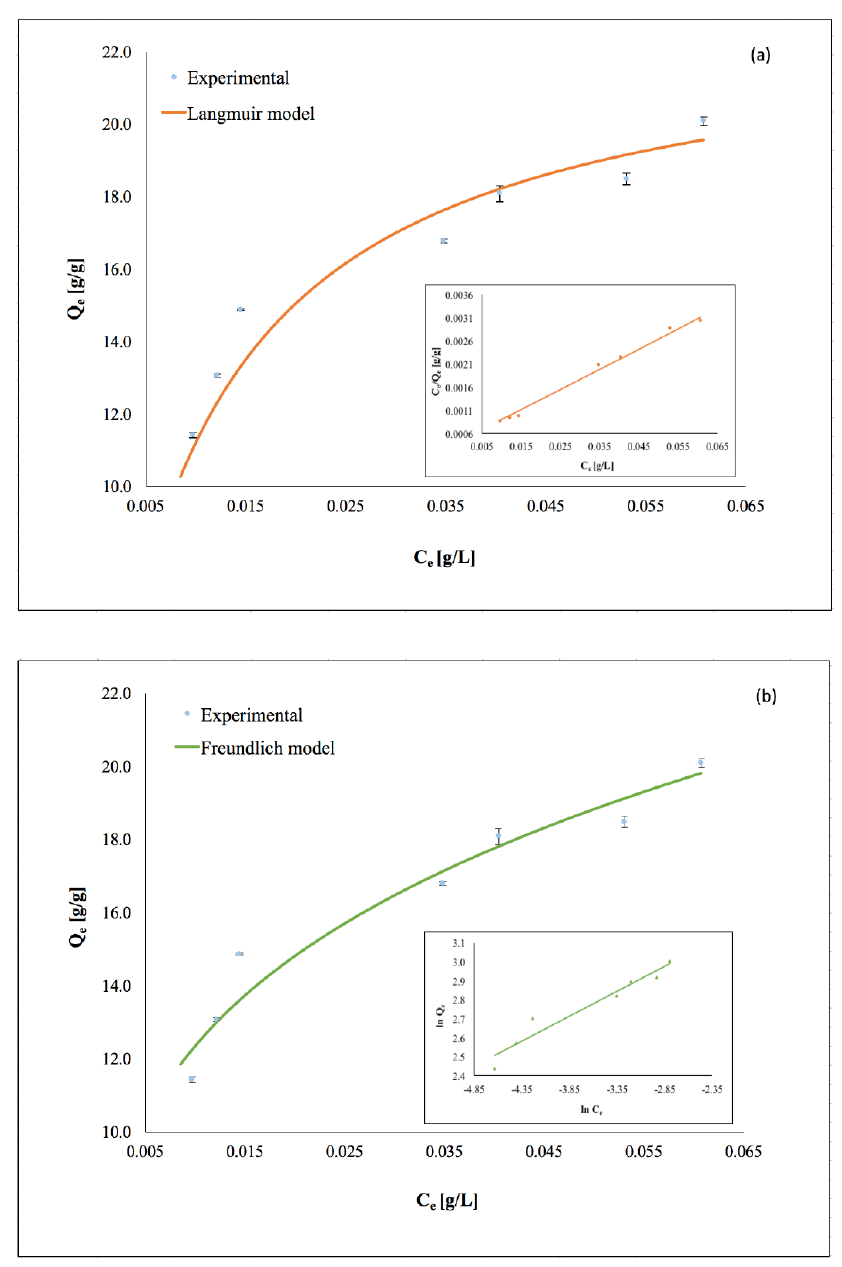
Figure 6. Experimental adsorption isotherm of microwave-synthesized magnetite particles on the C. vulgaris cells at 25 °C, fitted with ( a ) Langmuir model and ( b ) Freundlich model; pH = 7, rpm = 450, C. vulgaris cell concentration 0.22 g L −1 . Table 4. Parameters estimated using the Langmuir and Freundlich models.